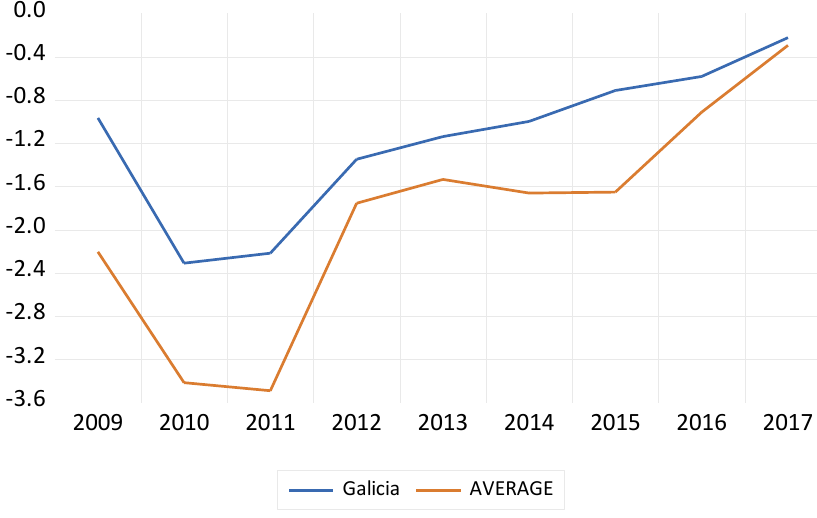
Figure 2 : Regional public deficit dynamics. Values in percentage of